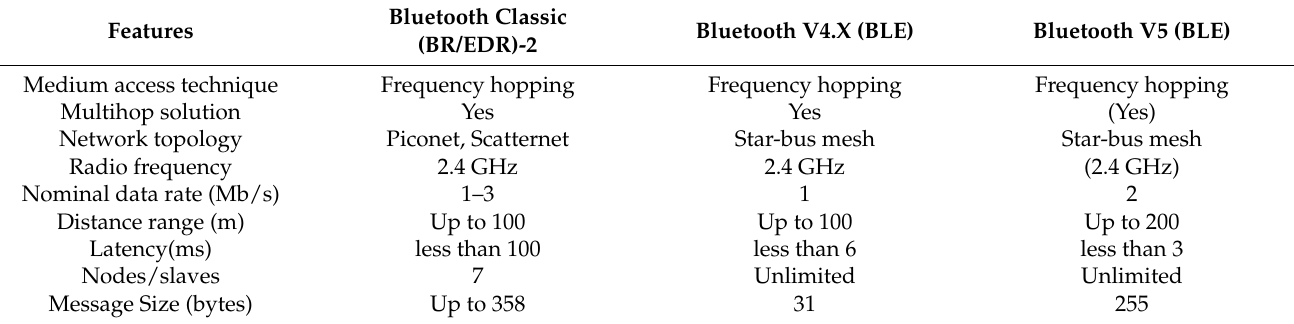
Table 1. Technical details of Bluetooth